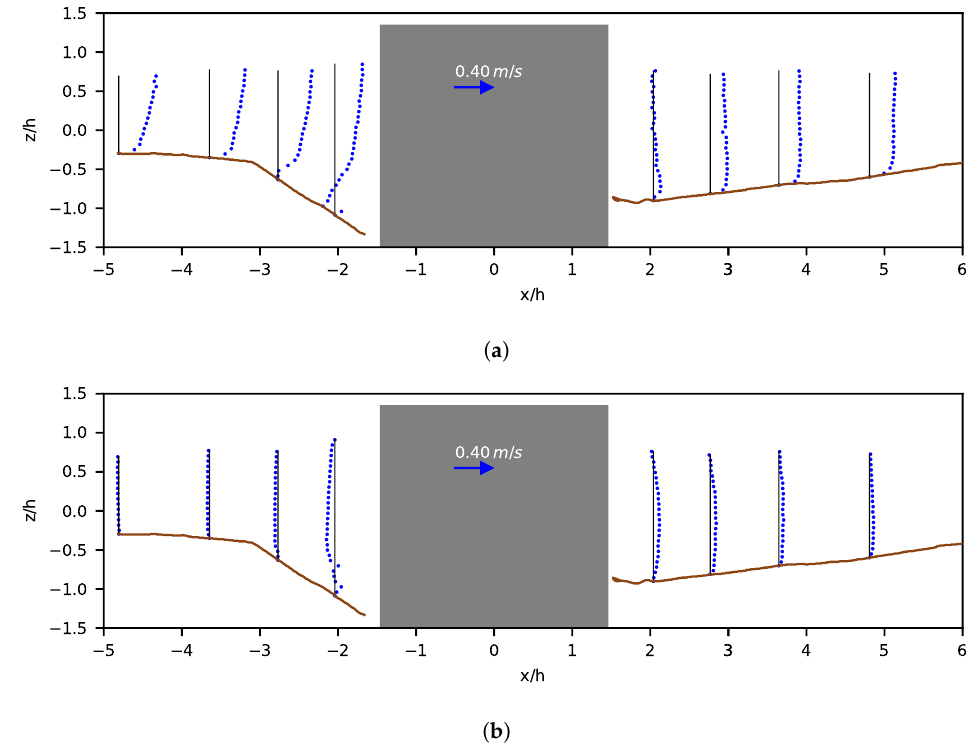
Figure 12. Vertical profiles of the velocity components along the pier’s mid-plane for Exp . 2 U Ebed . ( a ) Stream-wise component of velocity ( u ). ( b ) Vertical component of velocity ( w